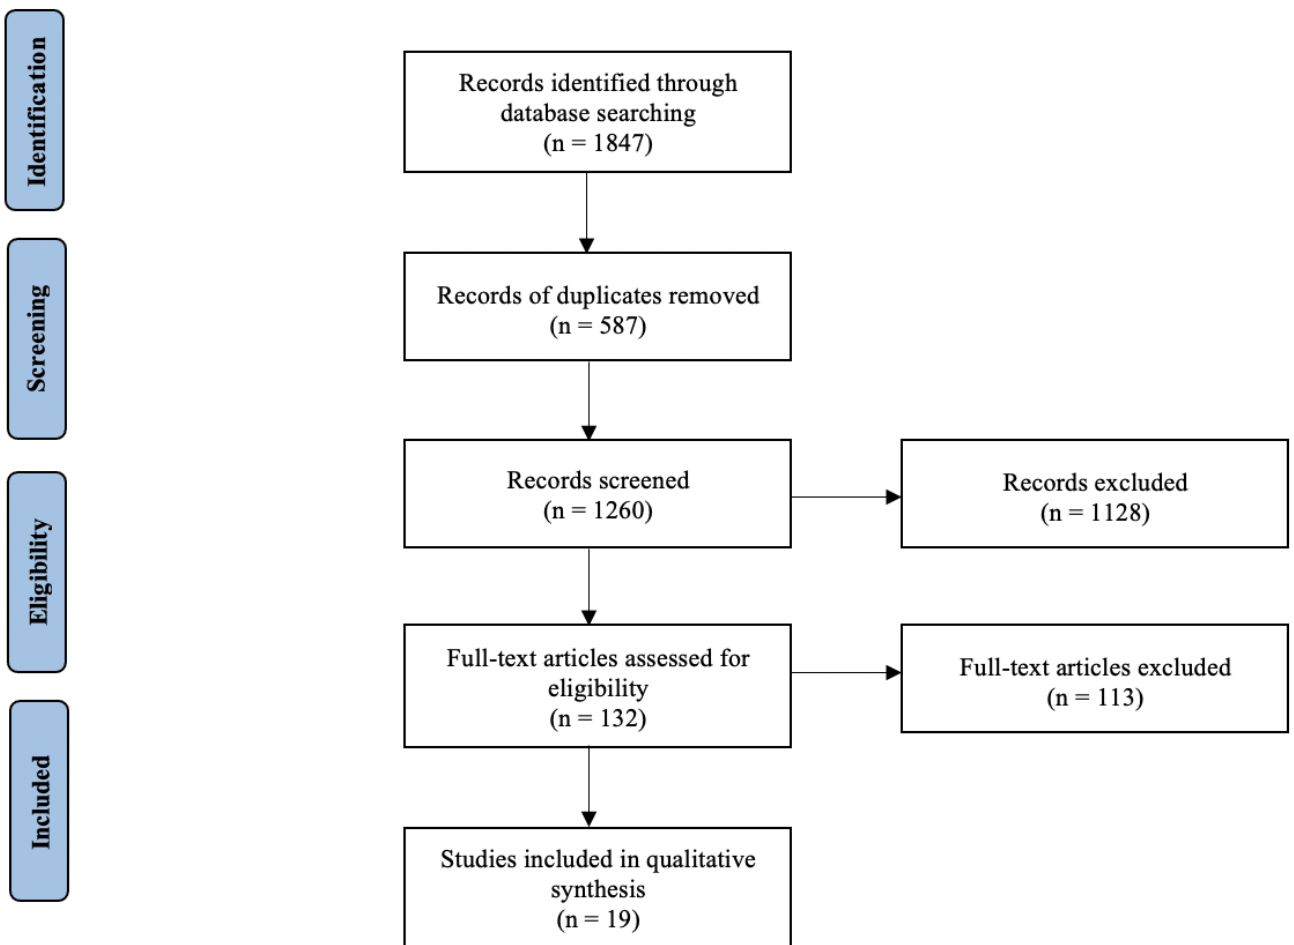
Figure 1. PRISMA flow diagram detailing the systematic search process.